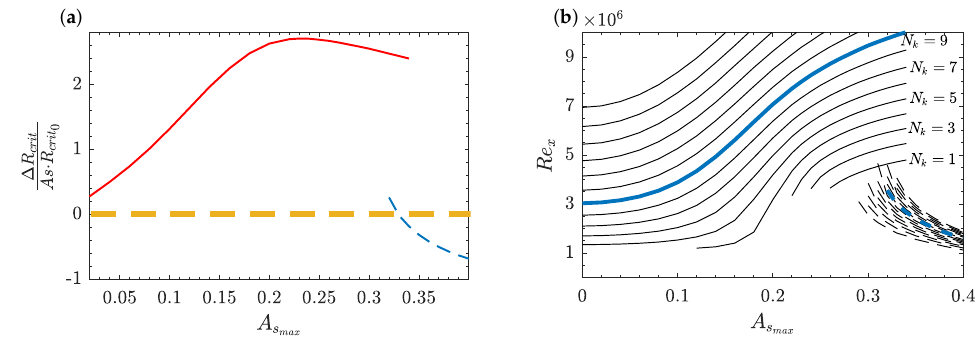
Figure 8. ( a ) Effect of the maximum streak amplitude on the stabilization efficiency, red solid line represents TS waves, blue dash line stands for SI perturbations. ( b ) N -factor isolines over Reynolds number and maximum streak amplitude chart, spaced as N k = 1,2, . . . ,15. Solid (dash) thin black line displays damping of TS waves (rise of SI perturbations), with N k = 9 highlighted with a thick solid (dash) blue